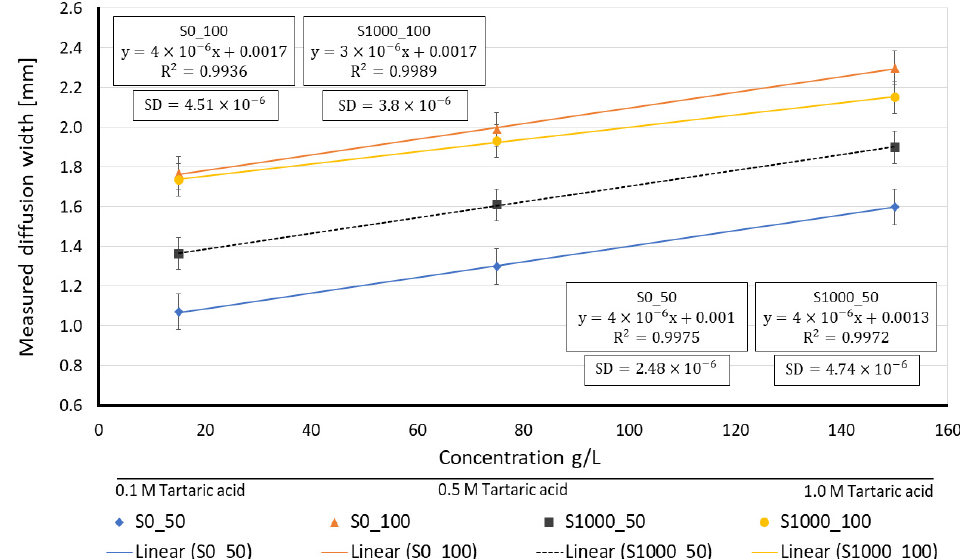
Figure 13. Calibration plot based on the average measured diffusion widths at the measurement line for different concentrations of tartaric acid. (SD = standard deviation).